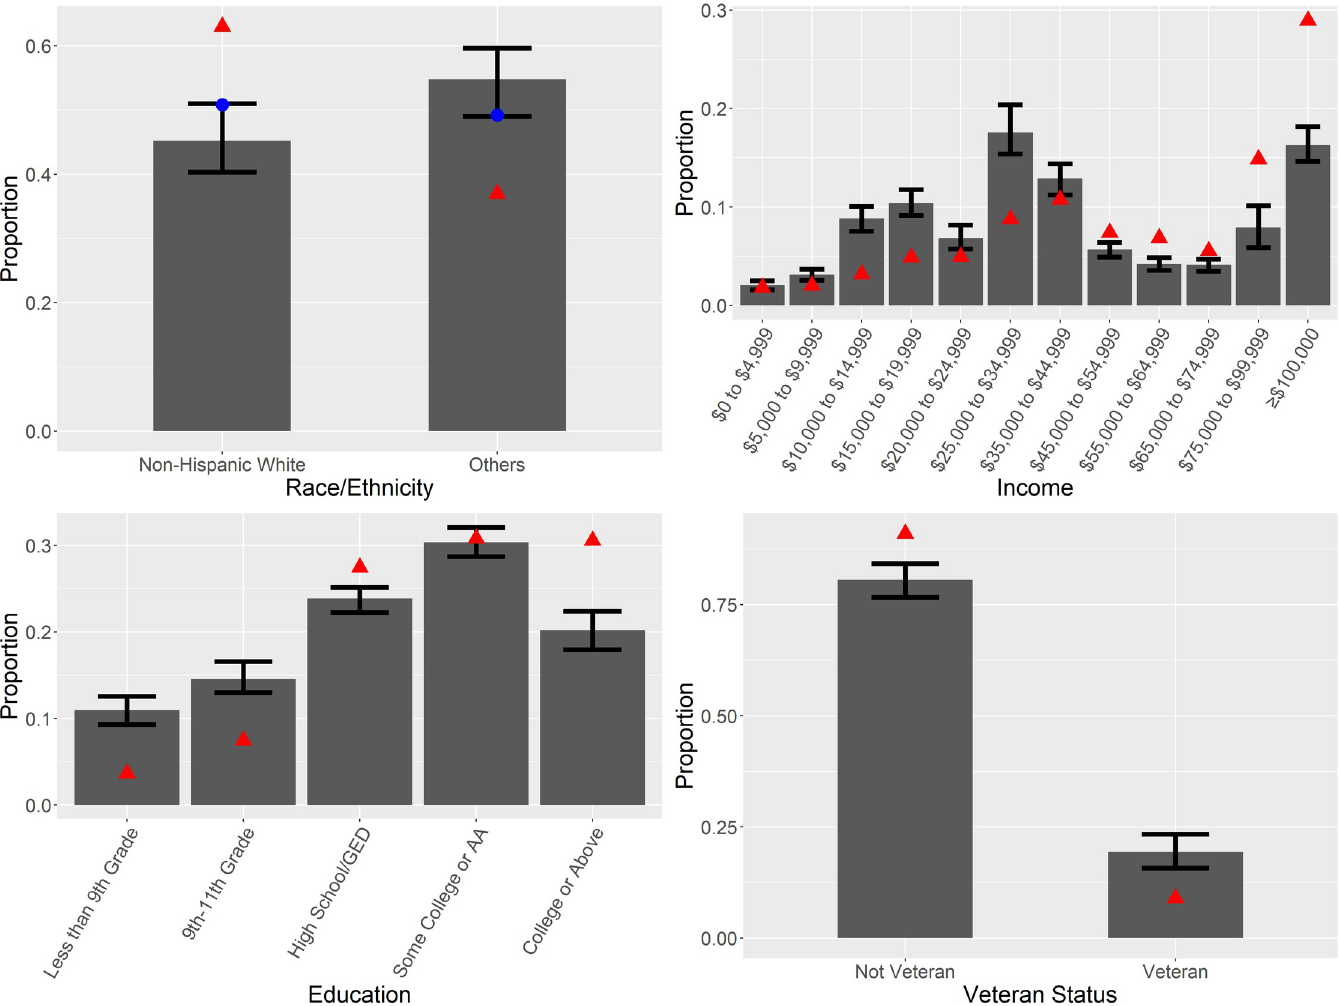
Fig 2. Simulated proportions of deaths by race/ethnicity, income, veteran status, and education level. Panels show mean and 2.5th–97.5th percentile range for the simulations (gray bars and whiskers), the CDC-reported proportions (blue circles, only for race/ethnicity), and the NHANES-estimated proportions for the general population (red triangles). AA, associate’s degree; GED, General Educational Development; NHANES, National Health and Nutrition Examination Survey.